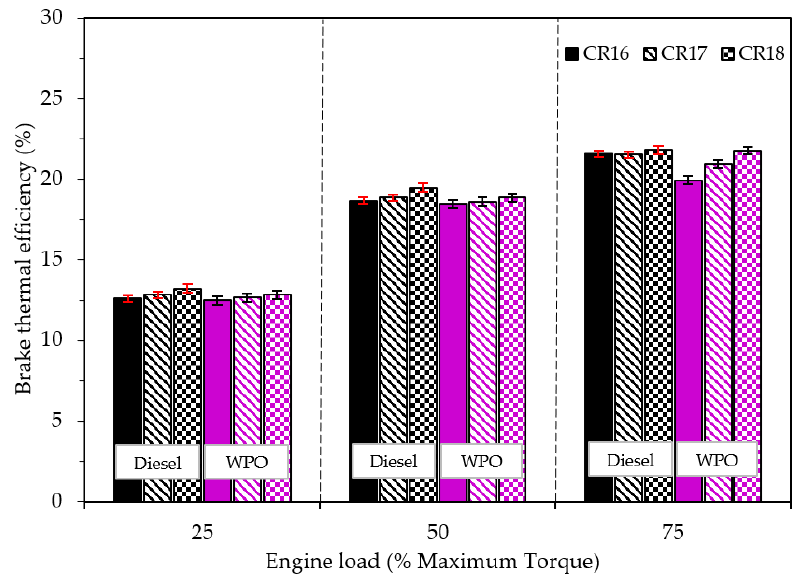
Figure 5. Variation of the brake thermal efficiency (BTE) with engine loads.